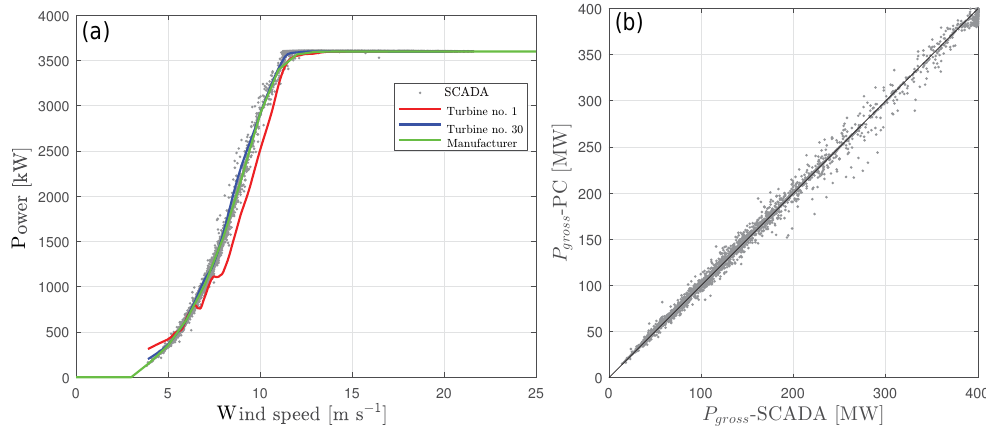
Figure 8. (a) Power curve of the turbines at the Anholt wind farm derived from the SCADA of free-stream turbines compared to the manufacturer power curve. (b) Gross wind-farm power derived from the SCADA for the free-stream turbines compared to that derived from the power curve (PC).